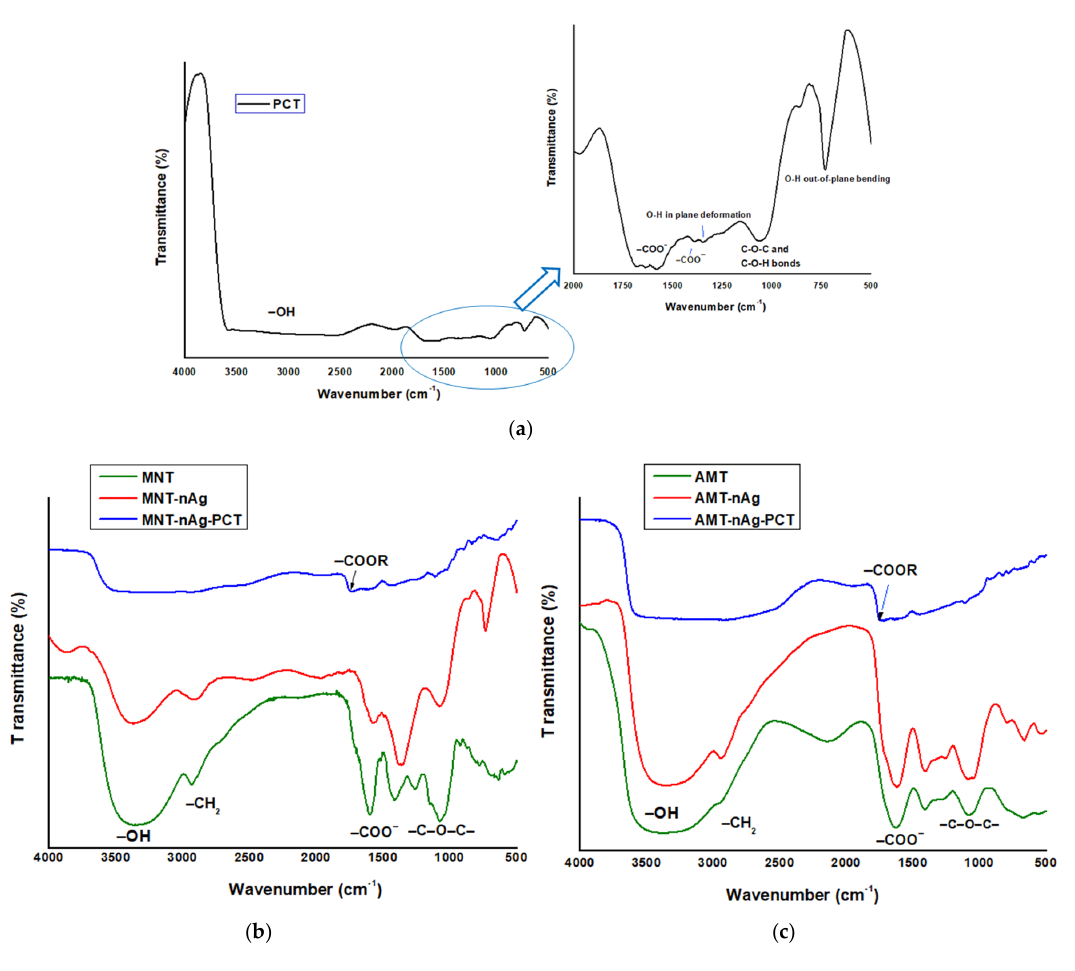
Figure 3. Fourier Transform Infrared (FT-IR) spectra of lemon pectin ( a ); and of materials generated from Mentha piperita ( b ) and Amaranthus retroflexus ( c ). Table 2. FT-IR bands assignment for plant-derived materials developed in this study.